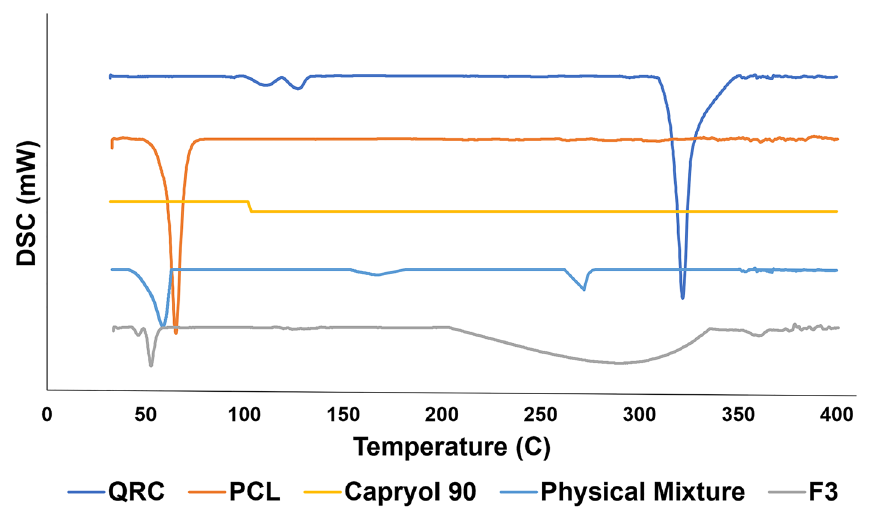
Figure 3. DSC charts of QRC, PCL, Capryol 90, physical mixture and